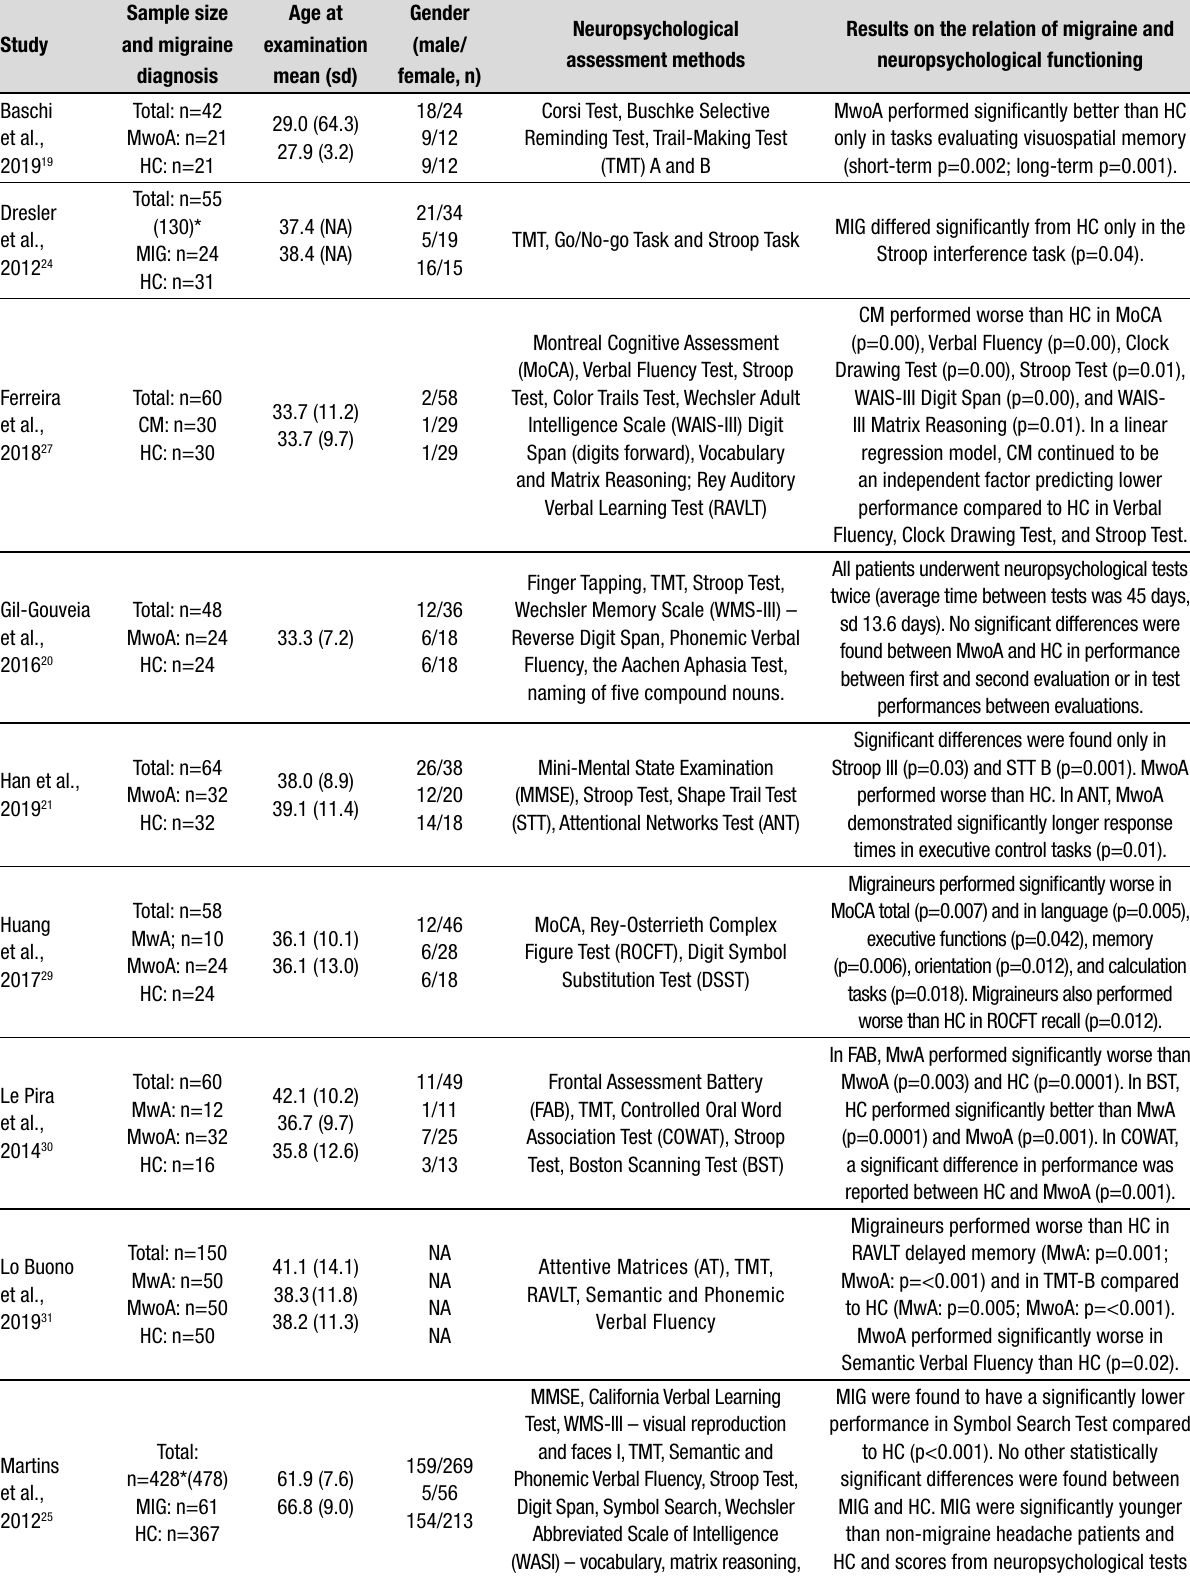
Table 1. Description of the studies reviewed and the neuropsychological findings comparing migraineurs and healthy controls. Sample size Study